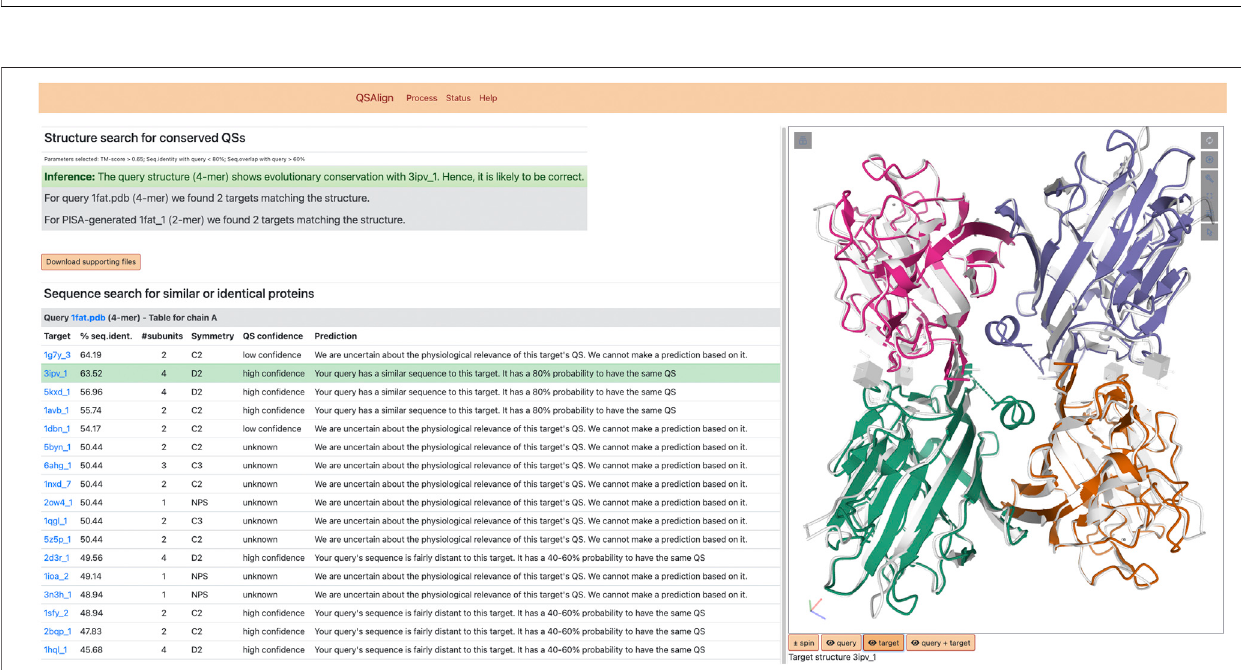
FIGURE 2 | Results of QSalignWeb. The result page of QSalignWeb describes the prediction made by QSalign based on the superposition with homologous QSs. The superposition of the two QSs based on which the prediction is made is shown on the right-hand side. A table displays the result of the search of non-redundant QSs with a sequencesimilartothequery.Inthislist,theclosesthomologwithahigh-con fi